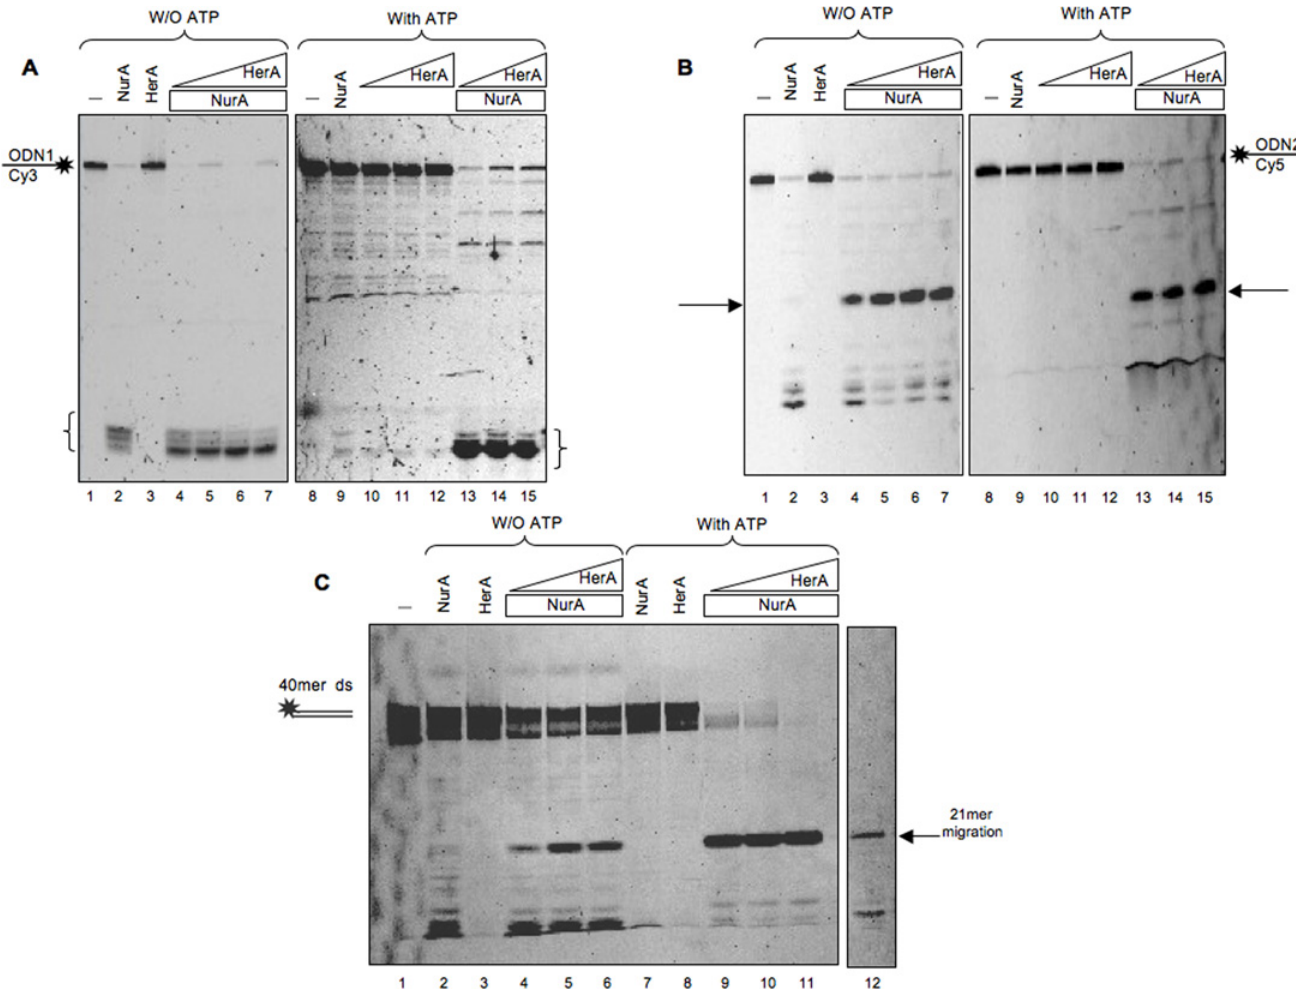
Fig 7. HerA modulates NurA nuclease activity on linear single-stranded DNA. NurA/HerA complex was analyzed for its nuclease activity on single- stranded DNA in the absence or in the presence of 5 mM ATP with ODN1 (A) or ODN2 (B) substrates. The proteins were incubated either separately in the absence of ATP (A and B, lanes 2 and 3) or mixed together using increasing amounts of HerA (from 3 to 18 pmoles) and 18 pmoles of NurA (A and B, lanes 4 – 7). In the presence of ATP, 7.5 pmoles of NurA and increasing amounts of HerA (from 5 to 12 pmoles) were analyzed either separately (A and B lanes 9 – 12) or mixed (A and B, lanes 13 – 15). The main products are indicated by curly braces for ODN1 and arrows for ODN2. Lane 1 refers to a control lane in which no protein has been added. (C) NurA/HerA complex nuclease activity on double stranded DNA. ODN1 has been previously annealed with its complementary strand in order to obtain a linear double-stranded DNA molecule (see Material and Methods and Table 1) 19 pmoles of NurA and 12 pmoles of HerA were analyzed separately without or with 5 mM ATP (lanes 2 – 3 and 7 – 8, respectively). Then the same amount of NurA was analyzed in the presence of increasing amounts of HerA (from 3 to 12 pmoles) in the absence or in the presence of ATP (lanes 4 – 6 and 9 – 11, respectively). Lane 1 refers to a control in which no protein was added in the assay. Lanes 12 refers to a 21 mer Cy5 used as